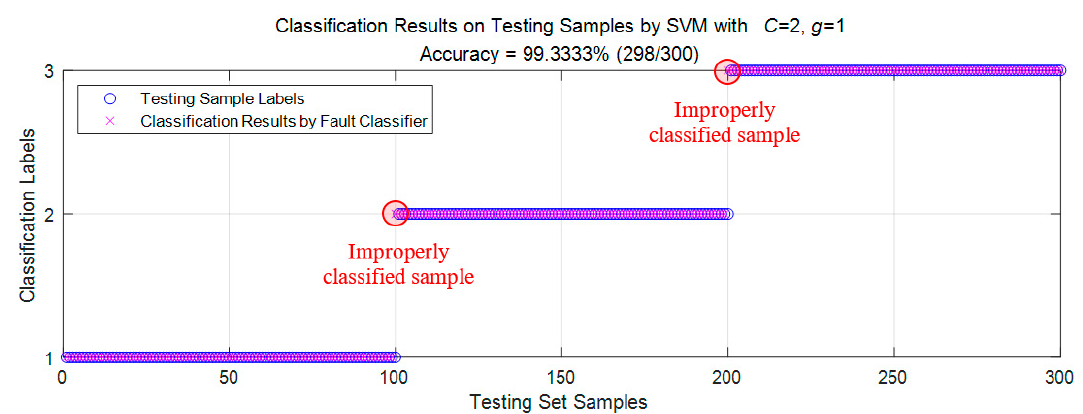
Figure 12. Fault classification results on testing set by support vector machine (SVM) with assigned parameters C = 2 and g = 1 (classification accuracy = 99.33%).